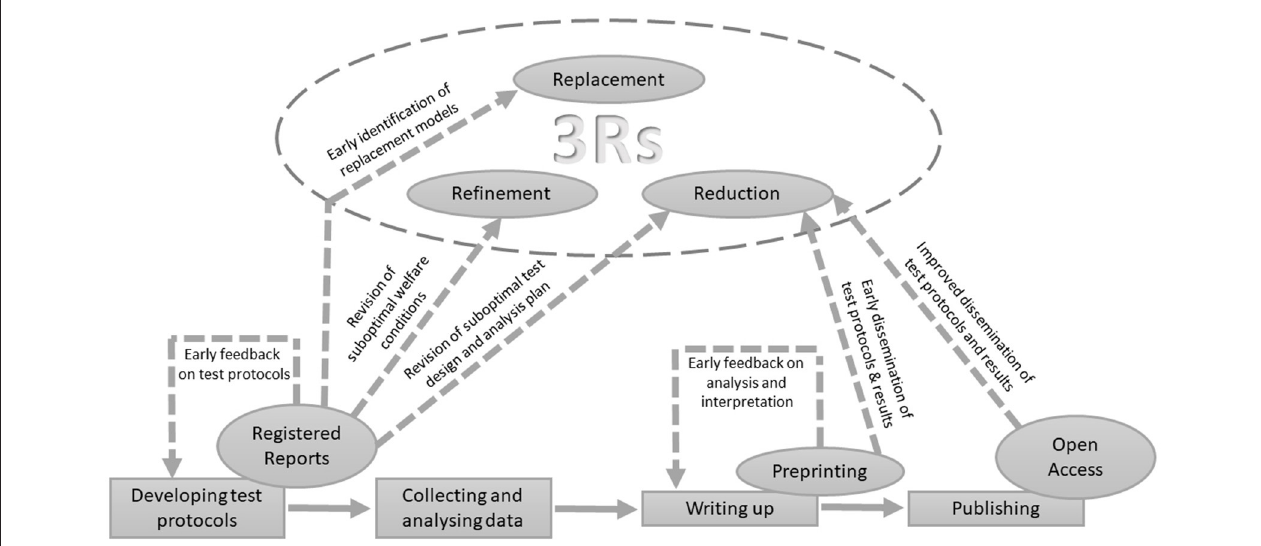
FIGURE 1 | Graphical illustration of the most apparent animal welfare benefits by implementing Open Science practices such as pre-registrations/Registered Reports, preprinting, and Open Access